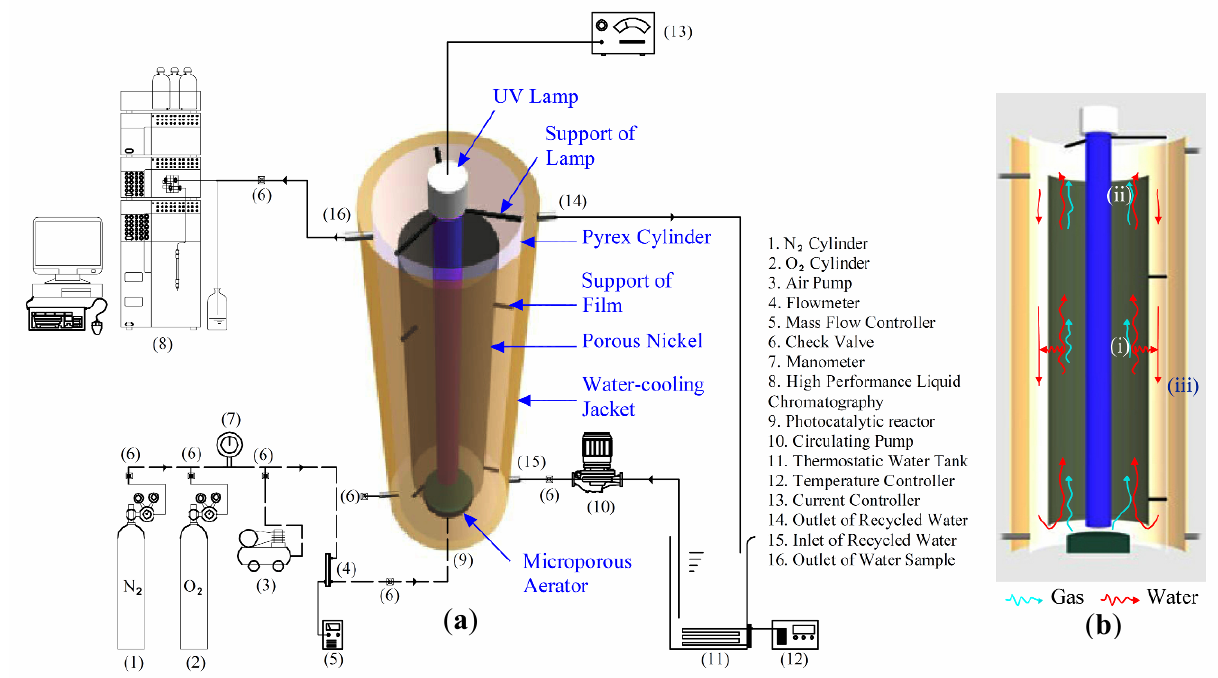
Figure 1. Schematic diagram ( a ) and cross section ( b ) of the tubular photocatalytic